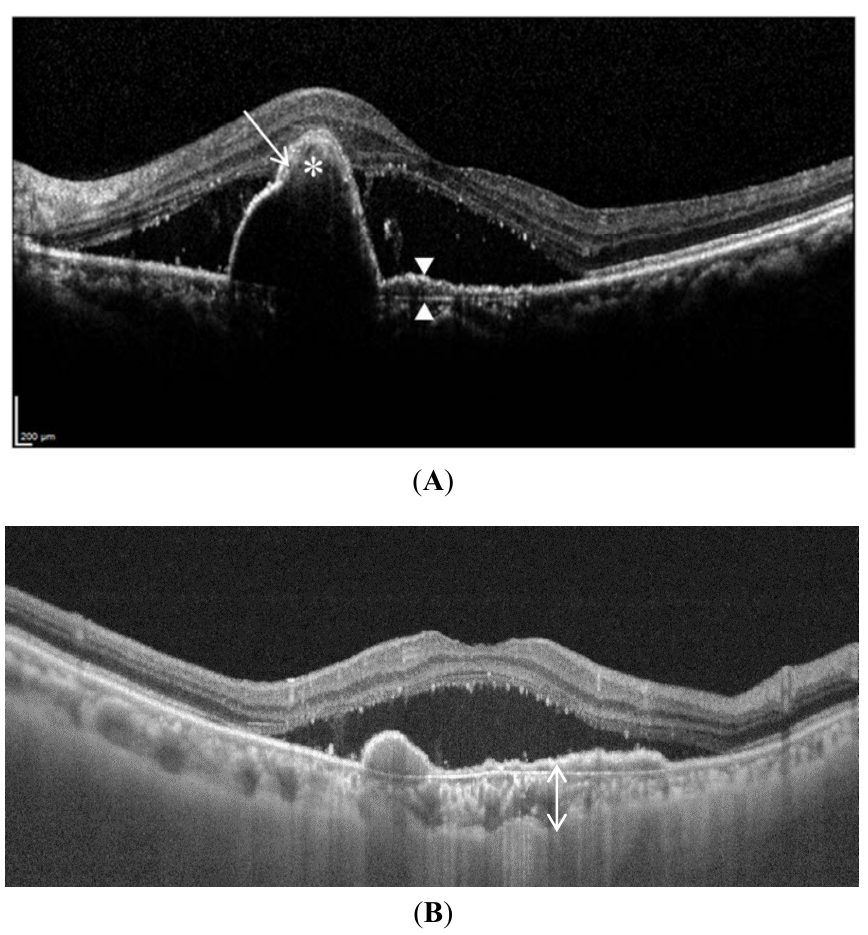
Figure 4. Tomographic features of polypoidal choroidal vasculopathy (PCV): Spectral domain optical coherence tomography (OCT) ( A ) shows peak like elevation of the RPE with underlying moderate reflectivity within the peak (asterisk), tomographic notch in the PED (white arrow) and double layer sign, consisting of two hyper-reflective lines (white arrowheads). Swept source OCT ( B ) is able to visualize the underlying thickened choroid (double headed